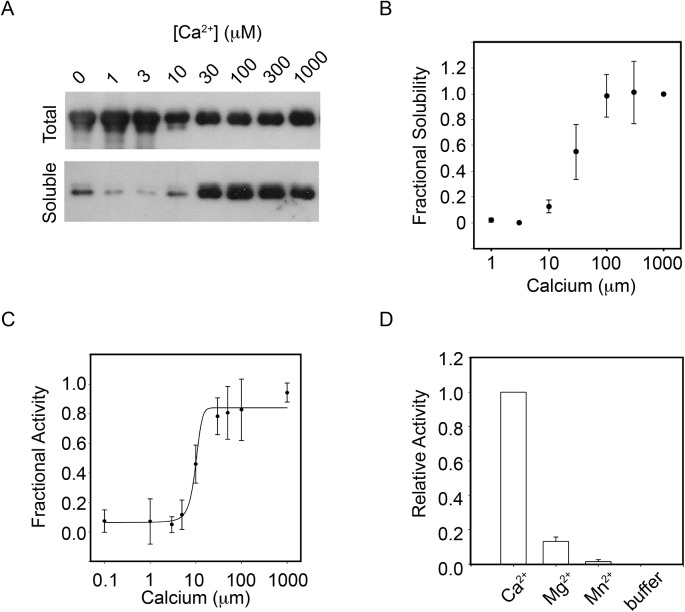
Ca2+-induced PrtS folding.The folding and activation of purified full-length PrtS was evaluated as a function of calcium binding. A, a representative western blot showing the calcium mediated refolding is shown. Protein was refolded in increasing calcium and filtered using a 100 kDa MWCO filter. The prefiltered samples are shown (Total) as a loading control with the eluate (Soluble) representing the compact, folded protein. B, densitometric analyses of the soluble fraction of PrtS are shown after refolding. The integrated band intensities are plotted against [Ca2+]. C, protease activity was assessed as a function of calcium in the refolding buffer using an enzymatic assay. Fractional activity is plotted against calcium concentration and fit using the Hill equation. D, the specificity of the PrtS refolding reaction was assessed using Mg2+ and Mn2+ cations. Endpoint fluorescence activity assays are shown for Ca2+, Mg2+ and Mn+ in conditions where Ca2+ is saturating. Data shown are mean ± standard deviation from at least three independent experiments.